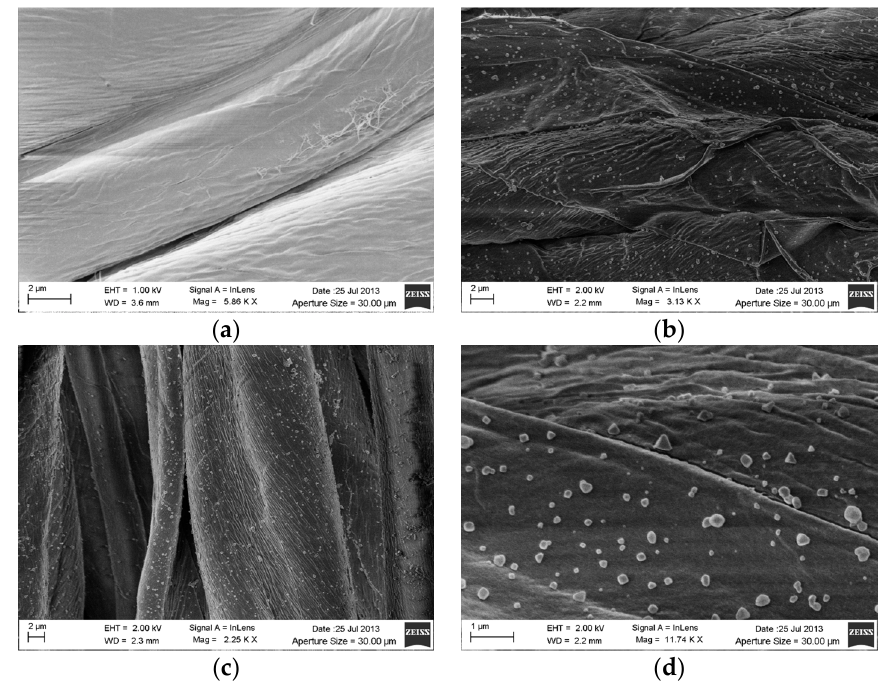
Figure 1. SEM analysis of distribution and dimension of the silver nanoparticles on the cotton fibres: ( a ) neat cotton fibers; ( b ) cotton fibers treated with 0.5 wt/v % silver; ( c ) cotton fibers treated with 4 wt/v % silver; ( d ) cotton fibers treated with 0.5 wt/v % silver at higher magnifications (×11740) for the evaluation of the dimension of the nanoparticles.